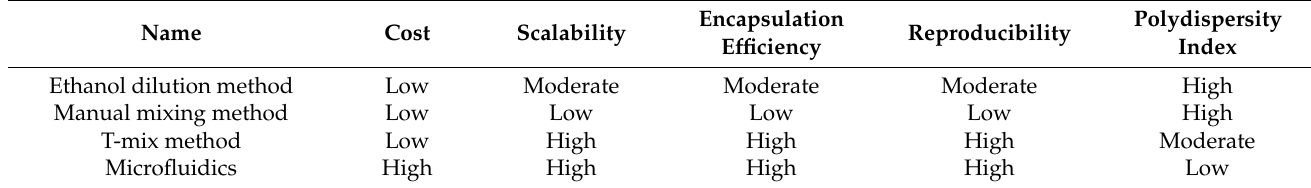
Table 4. Characteristics of the current laboratory methods for LNP